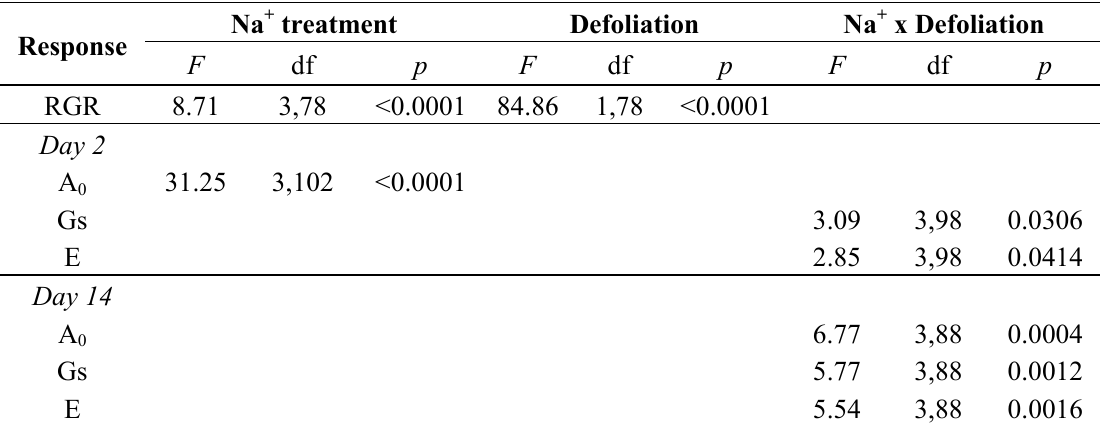
Table A1. Companion table to Table 1 in text, showing F , df, and p values for the full linear mixed model results. Blank values indicate interaction or no